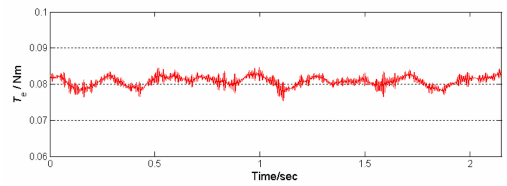
Figure 13. Electromagnetic torque of i d = 0